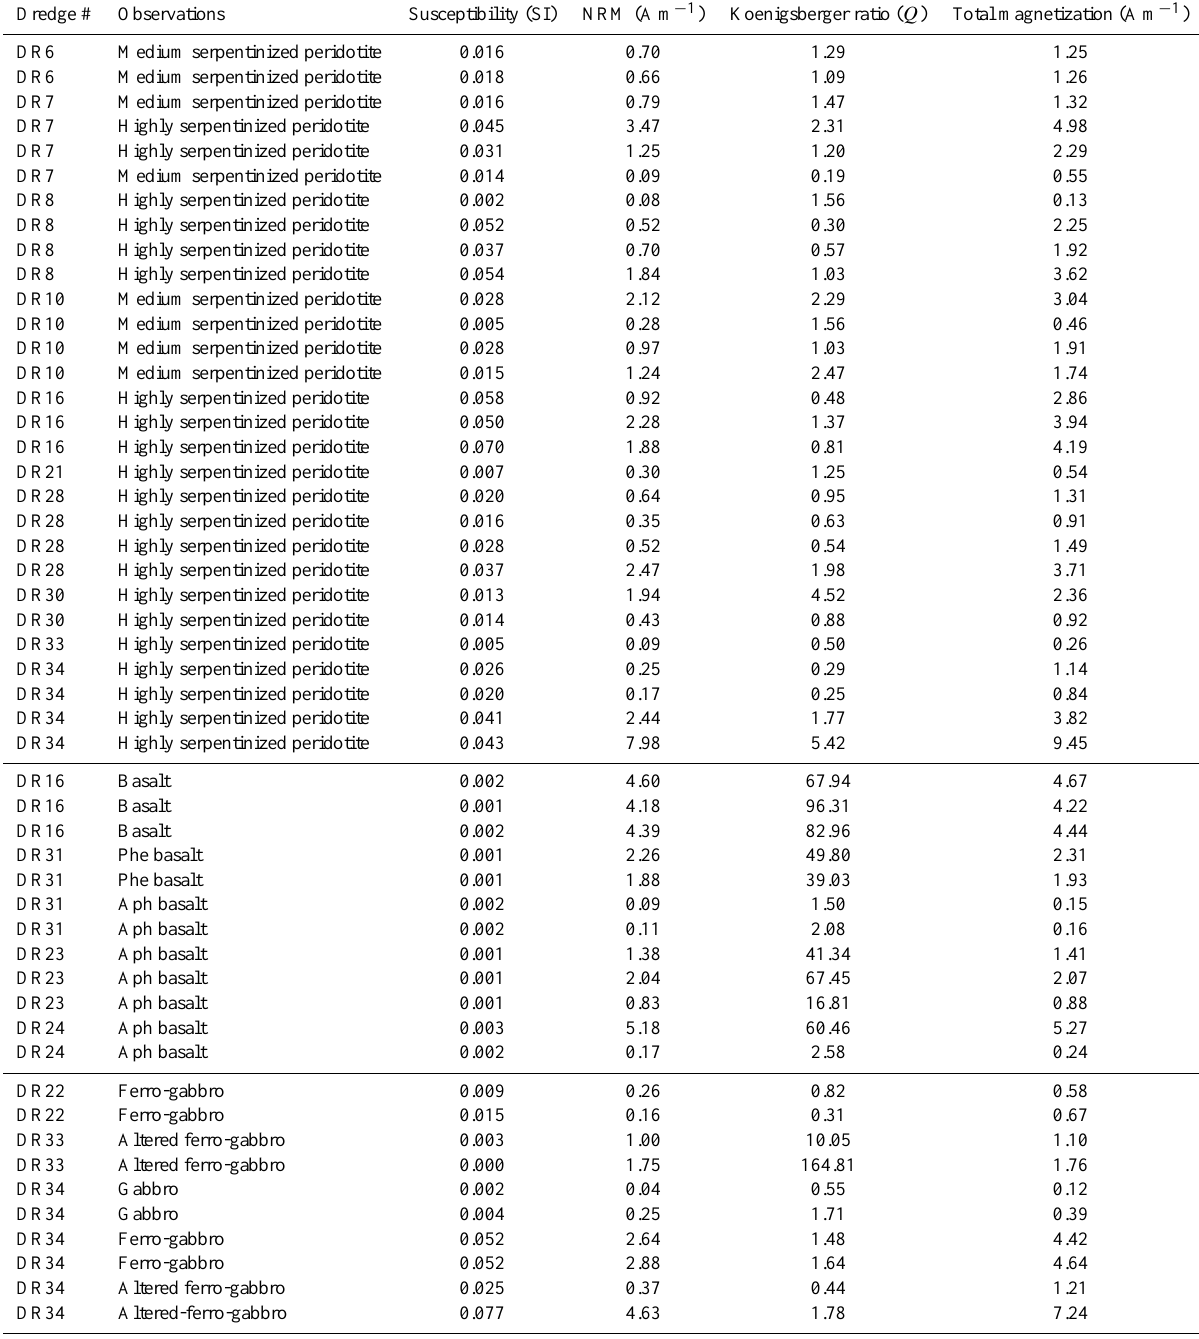
Table 1. Magnetic properties of the dredge samples. Highly serpentinized peridotites are more than 90% serpentinized and medium serpen- tinized peridotites are 75 to 90% serpentinized. Natural remanent magnetization (NRM), magnetic susceptibility and Koenigsberger ratio ( Q ) are plotted in Fig.